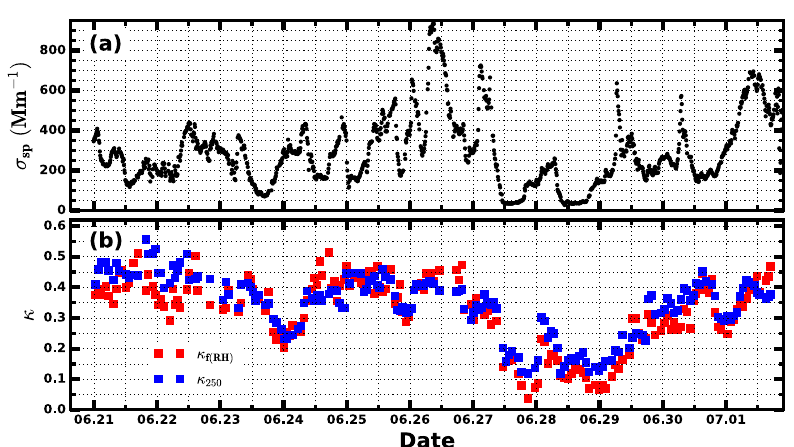
Figure 1. (a) The time series of σ sp at 550nm. (b) The time series of κ values derived from f ( RH ) measurements ( κ f( RH ) ) by combin- ing information on PNSD and BC, and time series of average κ values of aerosol particles at 250nm ( κ 250 ) , which are calculated from measurements of